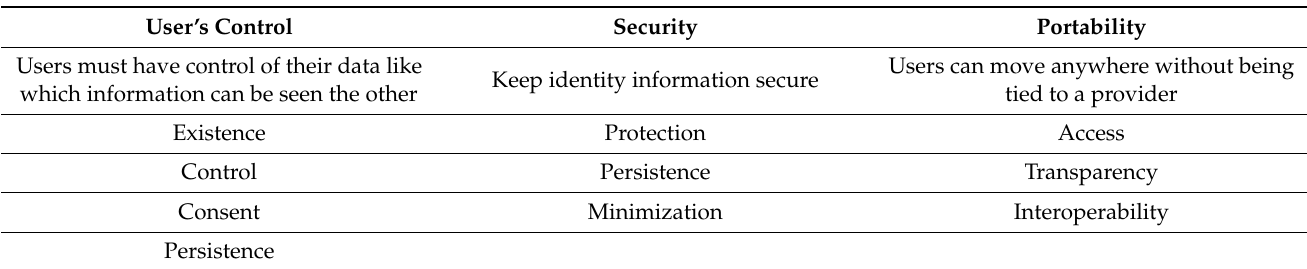
Table 1. Principle of